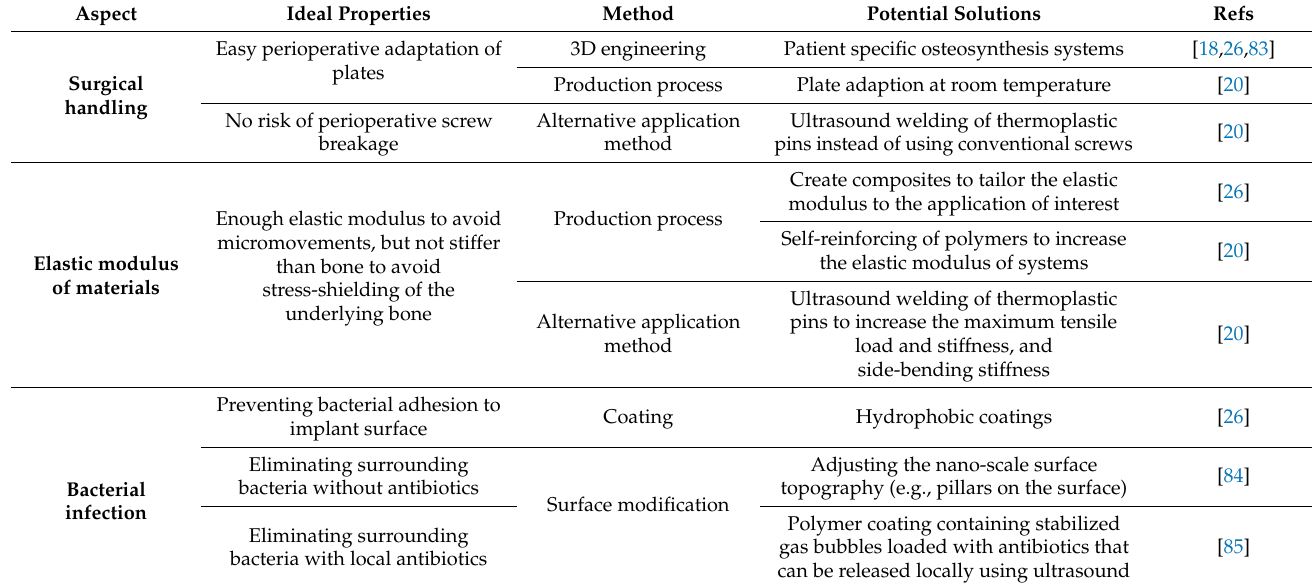
Figure 3. HE-sections (LM and LM-pol), SEM, and EDX by element and with overlay (red: carbon, and blue: nitrogen) of birefringent polymeric residual fragments of every osteosynthesis system at 48-month follow-up. HE, hematoxylin and eosin; LM, light microscopy; LM-pol, polarized light microscopy; SEM, scanning electron microscopy; EDX, energy-dispersive X-ray analysis; C, carbon; N, nitrogen; O, oxygen. Reprinted with permission from [25]. Table 2. Different aspects of biodegradable osteosynthesis systems accompanied with the ideal properties and the potential solutions to accomplish these